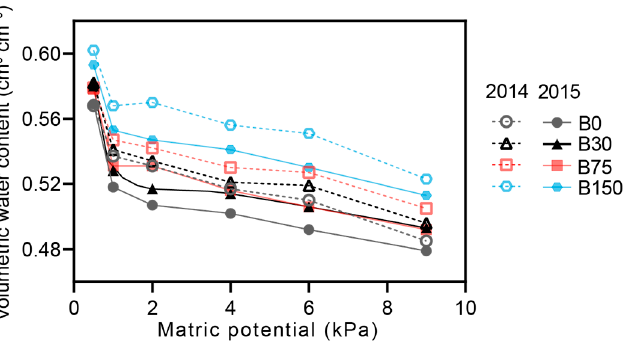
Figure 1. Water retention curve under the low suctions in the soils amended with biochar at various rates.